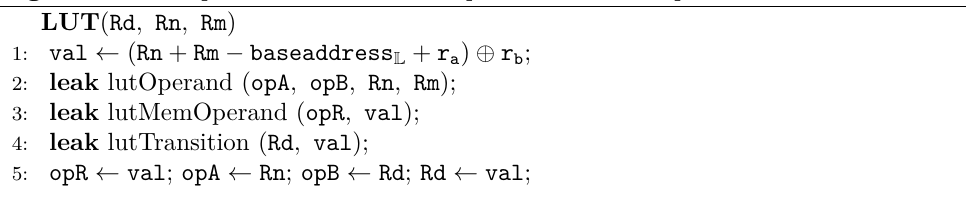
Algorithm 3 Simplified scVerif code to represent table lookups for formal verification. LUT ( Rd , Rn , Rm